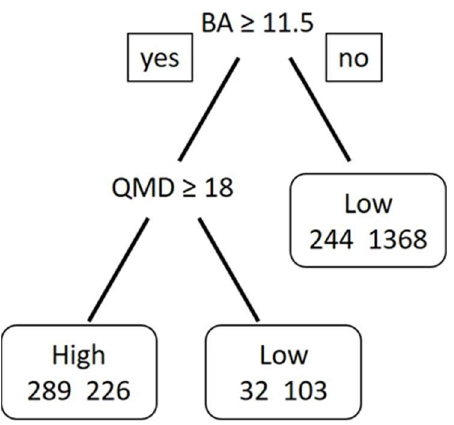
Figure 5. Simplest classification tree; misclassification rate 22%. In each box, the left value is the number of incorrectly classified subwatersheds and the right value is the number of correctly classified subwatersheds. Classification tree 5 in Table A1. See Table 1 for variable descriptions.